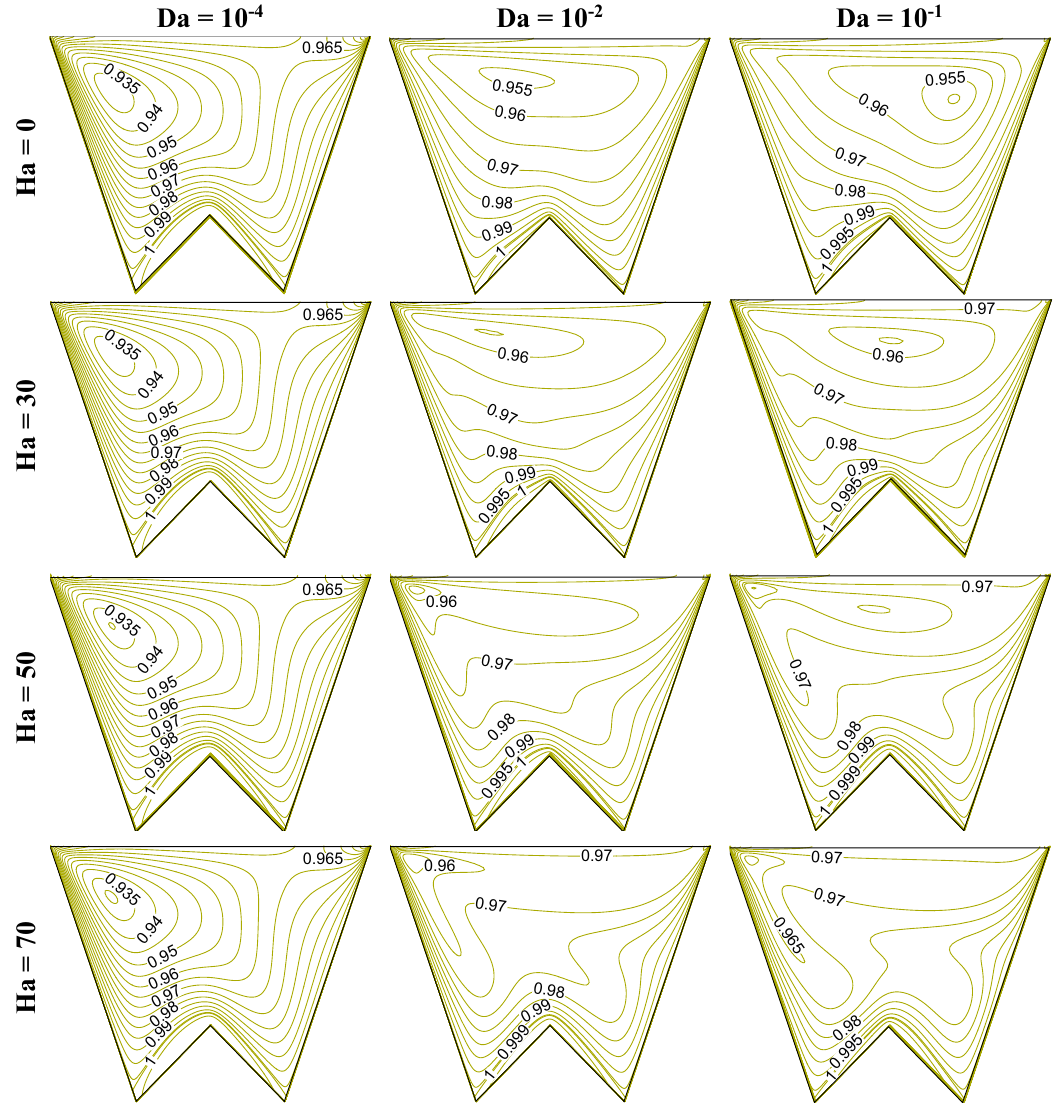
Figure 17. Isoconcentration of oxygen ( ζ ) at R b = 50, Le = 1, Pe = 1, Gr = 10 4 , m = 1, δ = 0.3, γ =